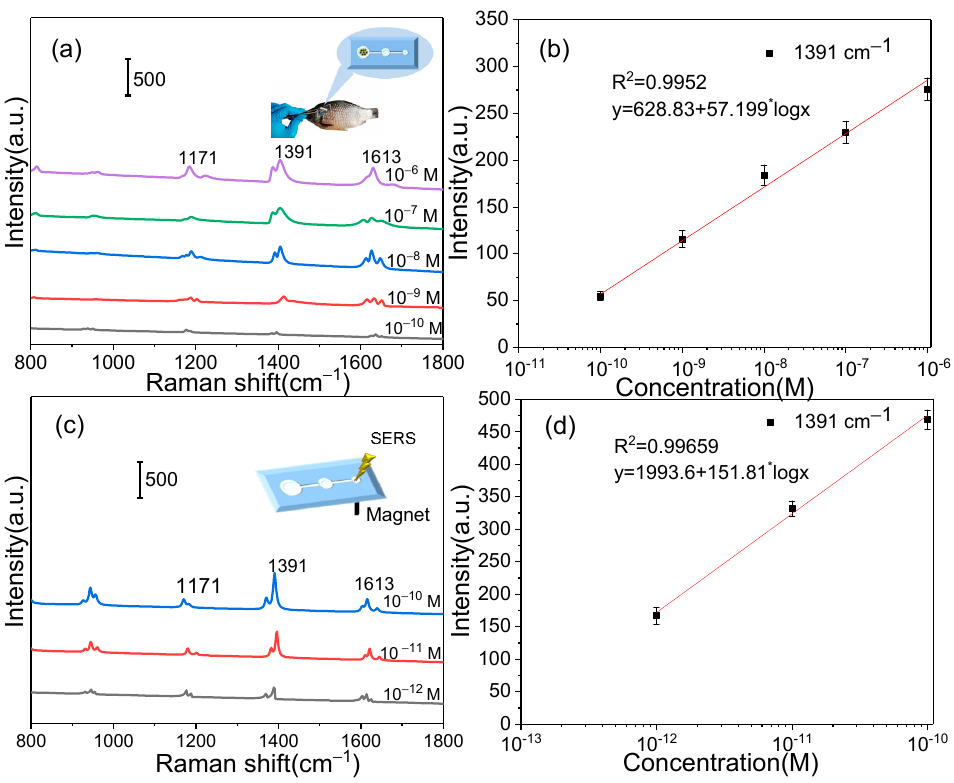
Figure 6. SERS spectra of MG measured from reservoir 1 ( a ) and reservoir 3 ( c ) by magnetic-fluidic SERS method, the corresponding dose-response curves of the Raman peaks at 1391 cm − 1 ( b , d ).